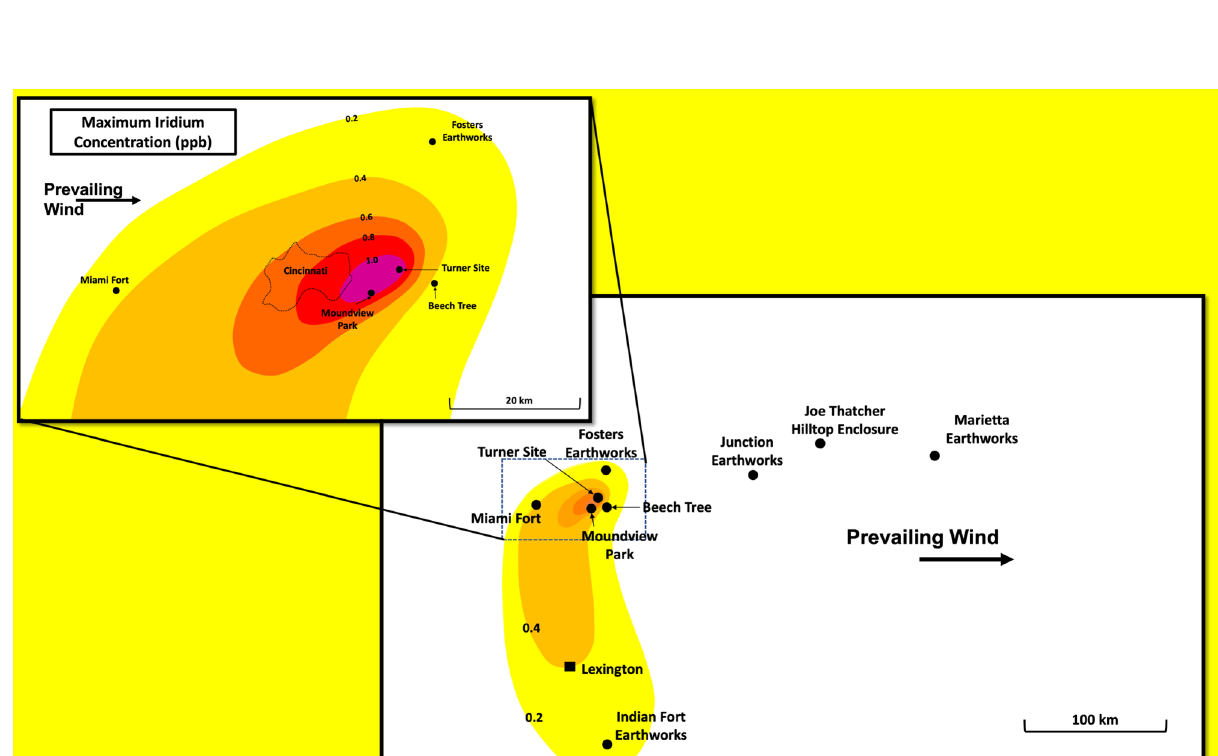
Figure 23. Geographic distribution of a positive iridium anomaly. Stephen Meyers and Stephanie Meyers used Microsoft PowerPoint for Mac Version 16.41 (www. micro soft. com) to create this